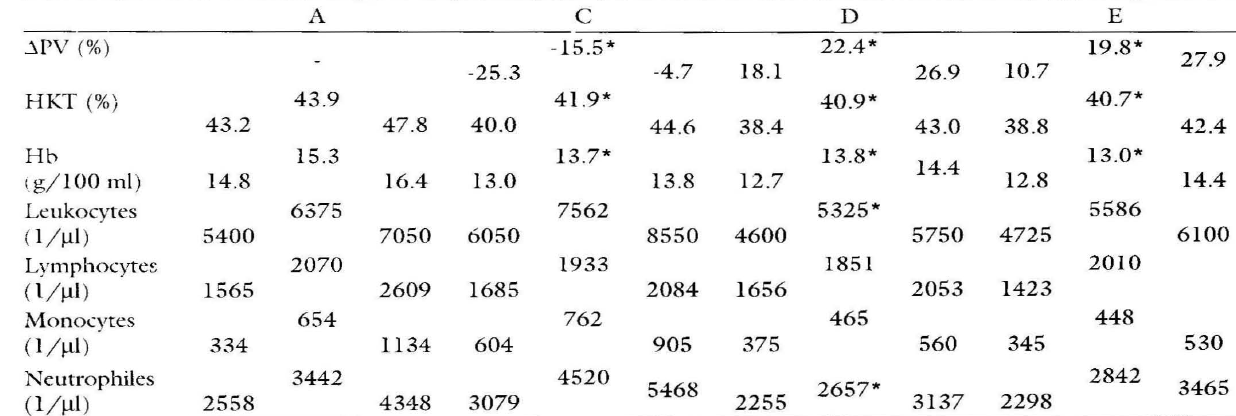
Table 2. Int1uence of the Oetzta! marathon (OEBM) on plasma volume CPV) as well as on red and white blood